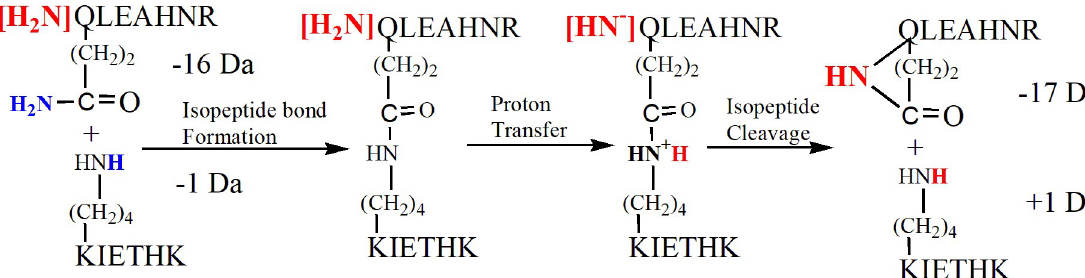
Fig 10. A proposed mechanism for cleavage of the isopeptide bond in the mass